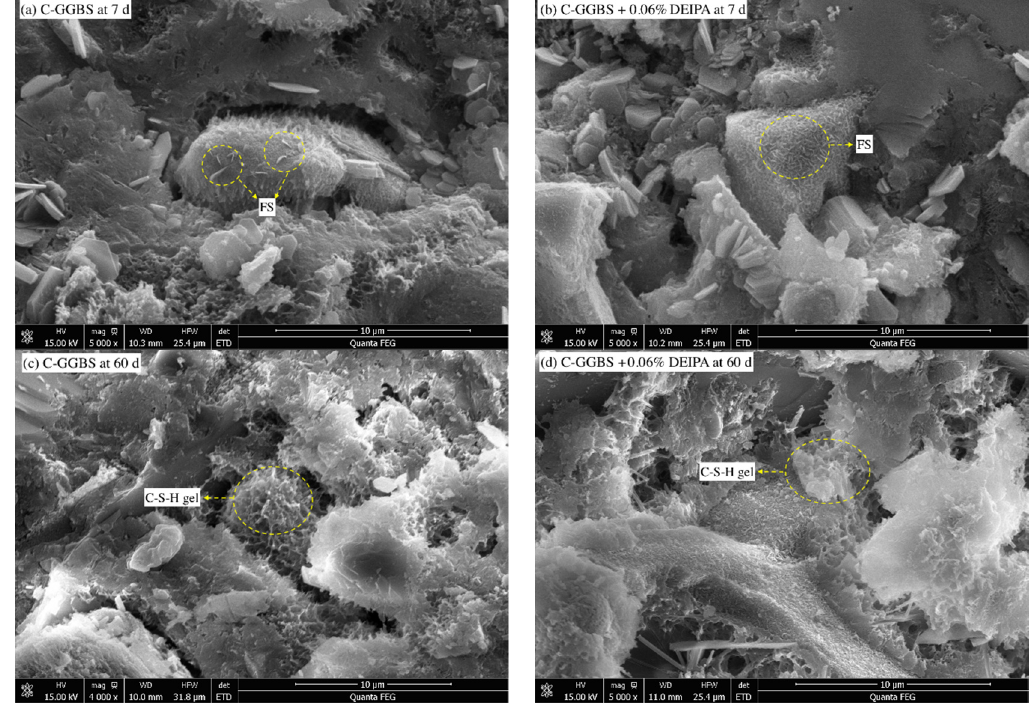
Figure 7. Scanning Electron Microscope (SEM) images of C-GGBS, ( a ) C-GGBS at 7 d, ( b ) C-GGBS with 0.06% DEIPA at 7 d, ( c ) C-GGBS at 60 d, ( d ) C-GGBS with 0.06% DEIPA at 60 d.